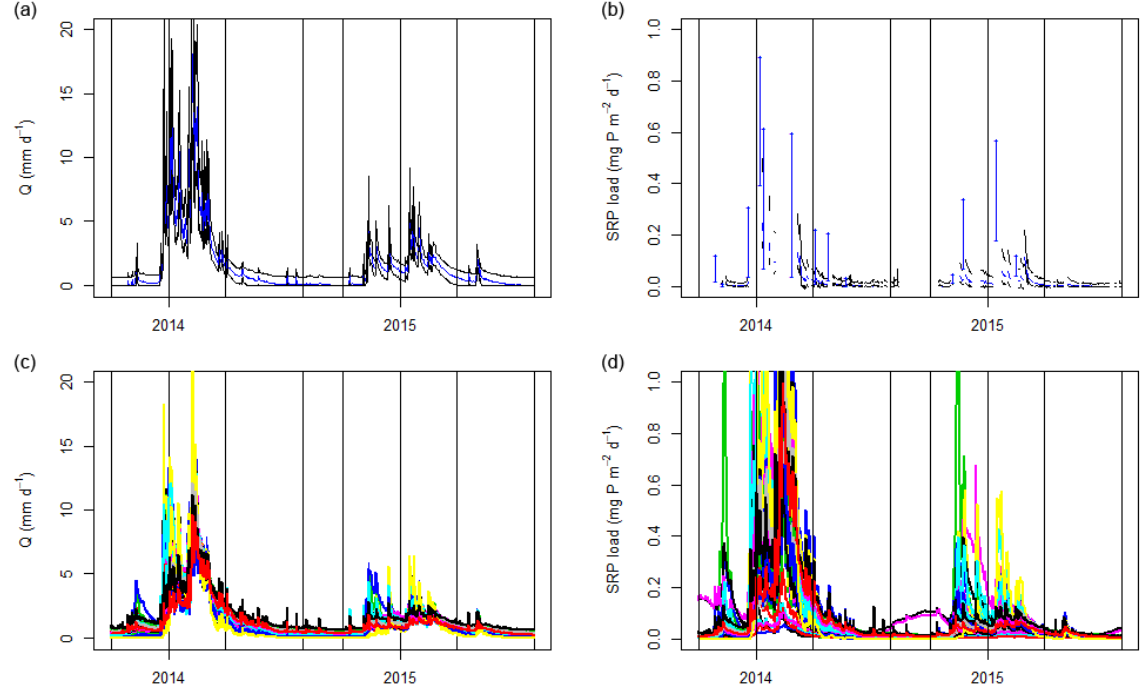
Figure 7. Acceptability limits for daily discharge (a) and SRP load (b) . Blue lines represent best estimates; black lines represent the accept- ability limits. Storm loads acceptability limits are represented by vertical blue lines. An example of 50 model runs simulating discharge (c) and daily load (d) . Black vertical lines represent the starting and ending dates for each season (Table